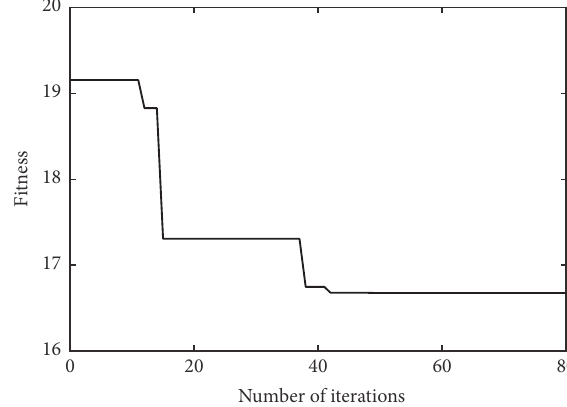
Figure 7: Fitness curve of